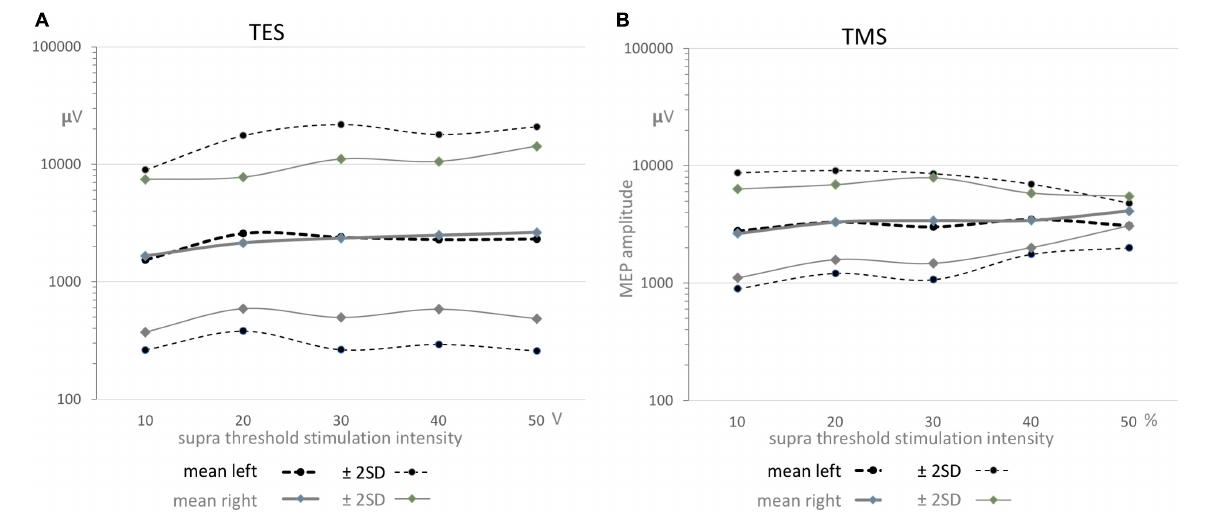
FIGURE 5 | Functions of the geometric means ± 2SD confidence intervals as function of supra threshold transcranial stimulation intensities for TES (A) and TMS (B) for both sides. All graphs show a gradual small increase. The means in graphs A and B are nearly equal, while between graphs A and B the mean values are about 1 mV higher for TMS. The full coverage of the wide ± 2SD intervals in all graphs predict the absence of significance between means within TES or TMS and also between sides for both stimulation modalities as presented in Table 5